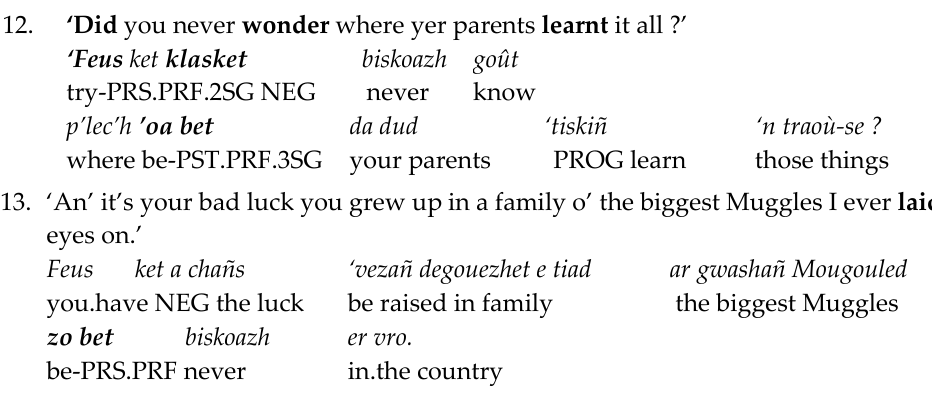
Table 1. Breakdown of perfect and PRS.PRF types in English, in corpus